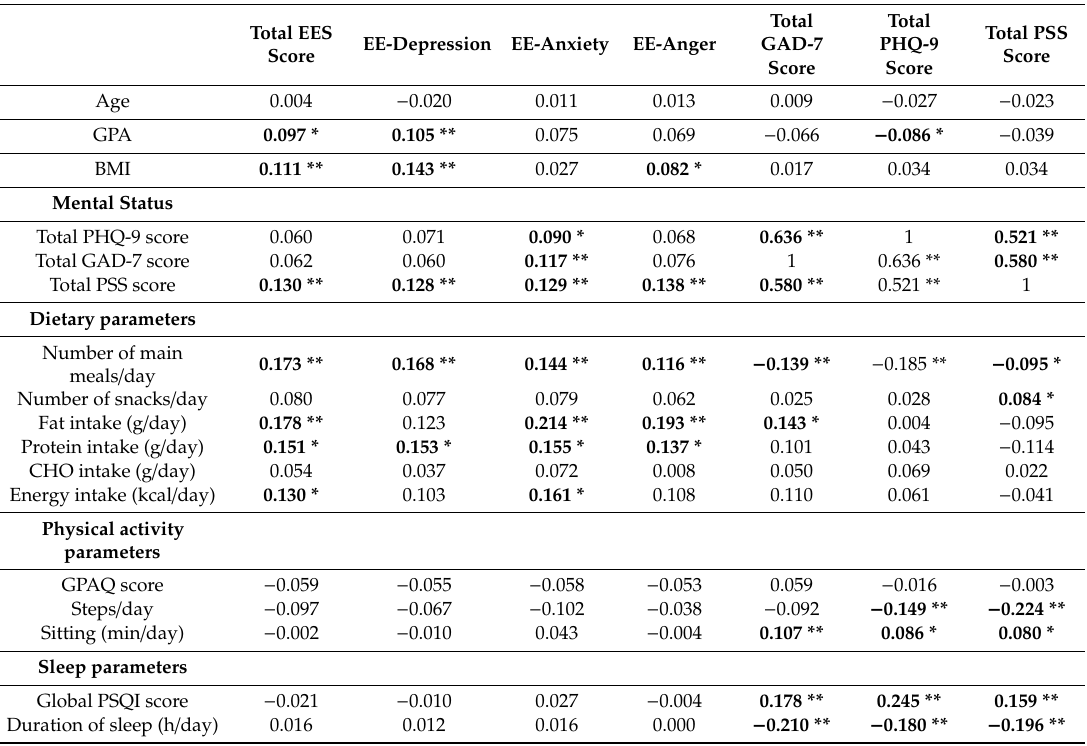
Table 3. Correlations between